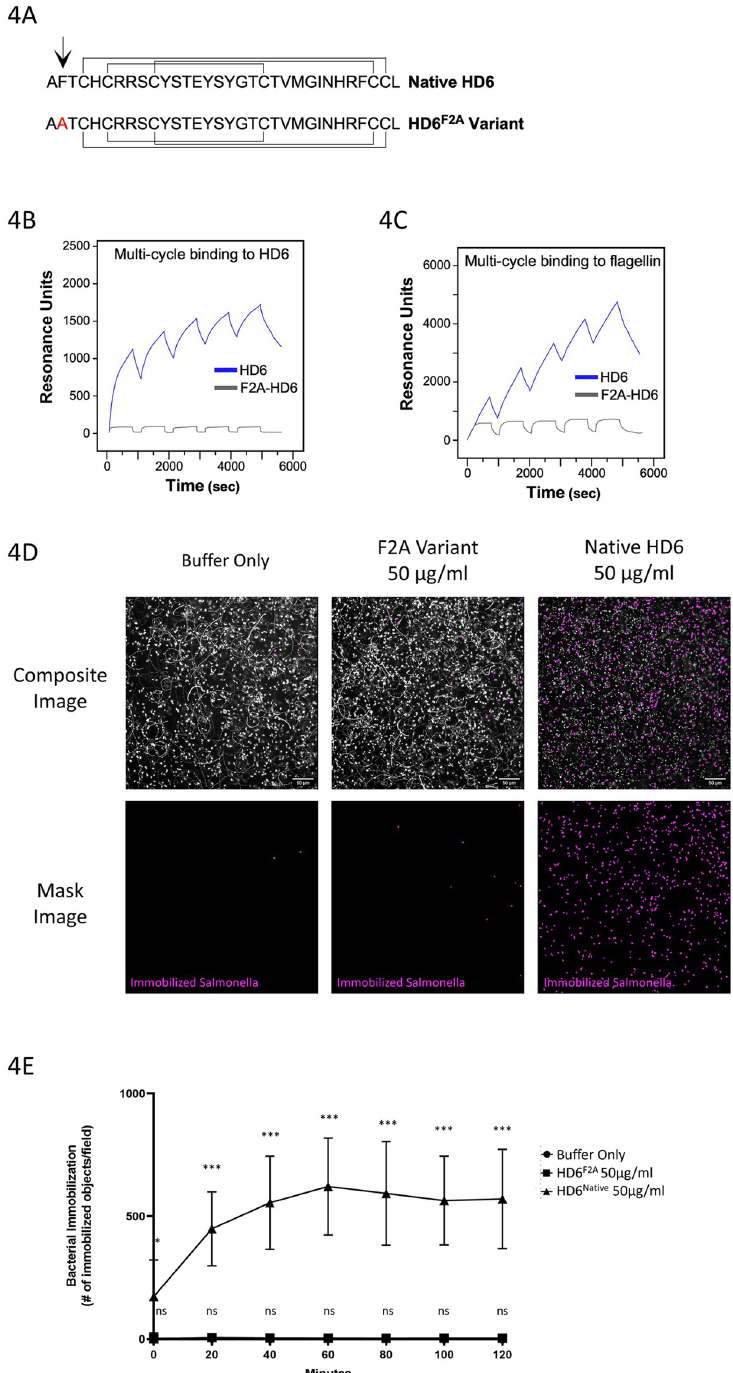
Fig 4. Structure-function analysis of HD6 immobilization activity. ( A ) Primary structure of native HD6 and the variant HD6 F2A peptides. Position two is highlighted with an arrow, with native F2 (phenylalanine) residue in black, variant A2 (alanine) in red. The connectivity of the three disulfide bonds found in HD6 and typical of α -defensins are depicted (Cys 1 -Cys 6 , Cys 2 -Cys 4 , Cys 3 -Cys 5 ). ( B, C ) Surface plasmon resonance (SPR) analysis of binding and self- association. ( B ) Graph showing multi-cycle SPR results of HD6 Native or HD6 F2A binding to immobilized HD6 Native . The SPR biosensor presented HD6 and the HD6 (blue) or HD6 F2A analytes traversed the biosensors at 20 μ l/min. Each 15 min cycle included a binding period of 12.5 min, followed by a wash period of approximately 2.5 min. ( C ) Graph showing multi-cycle SPR results of HD6 Native or HD6 F2A binding to immobilized flagellin. Analysis as in (B) except